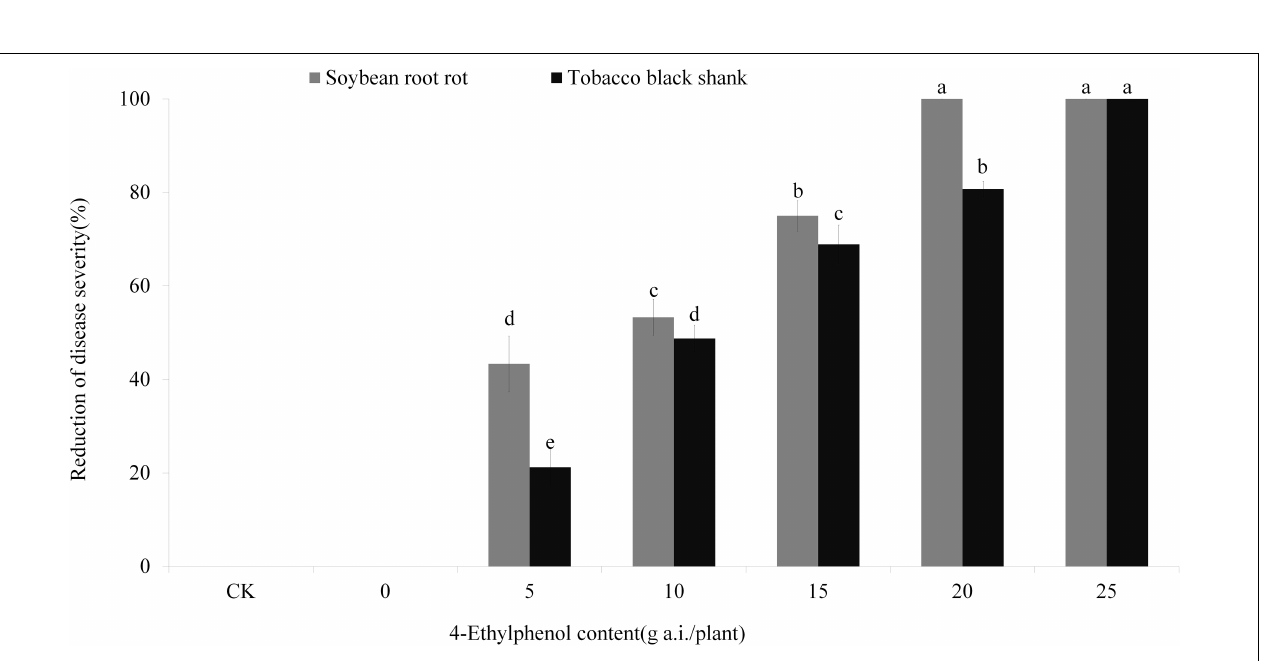
FIGURE 6 | Efficacy of 4-Ethylphenol on soybean root rot and tobacco black shank diseases. Data are the mean ± S.E. from three replicates per treatment.